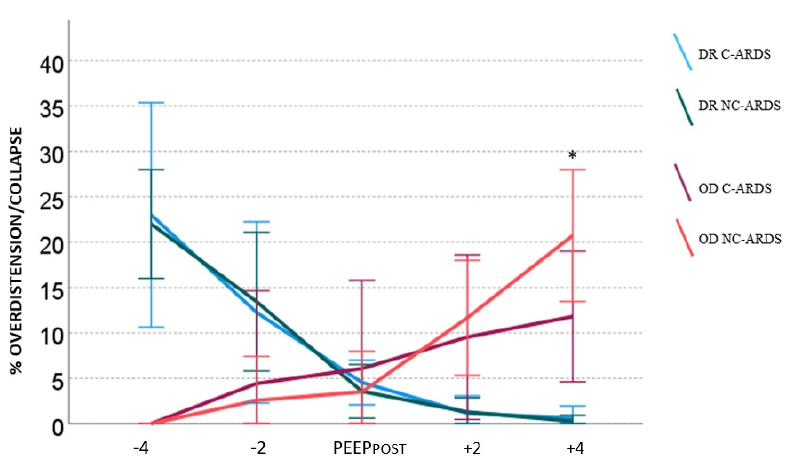
Figure 1. Overdistension (OD) and de-recruitment (DR) at different PEEP levels in the C-ARDS and NC-ARDS groups. Data are synthesized as means, and error bars represent standard deviation. * OD: p < 0.05 versus C-ARDS.